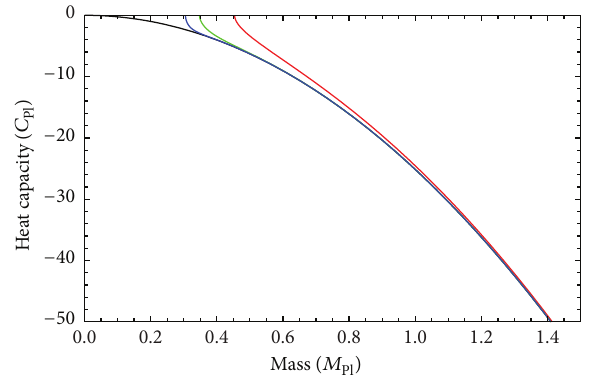
Figure 6: The heat capacity versus the black hole mass for the case 𝛼 = 1 . Curves are the Hawking result (black) and GUP 𝑛 = 2 (red), 𝑛 = 5 (green), and 𝑛 = 10 (blue),